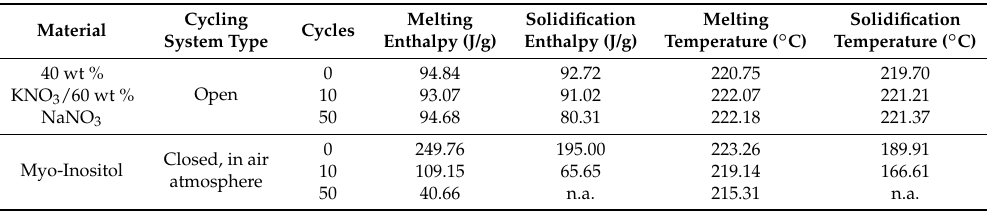
Table 9. Cycling stability tests